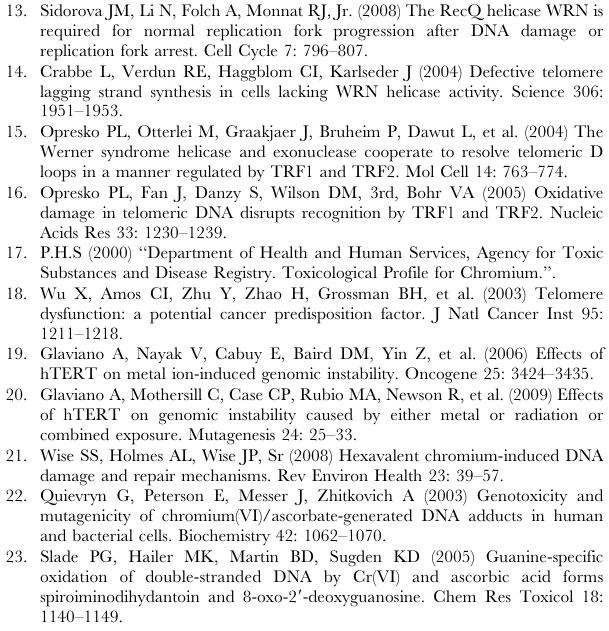
Table S1 Percent telomere defects (number of defects/number of chromosomes). The cells were exposed to the indicated Cr(VI) doses for 48 h and cultured in Cr(VI)-free medium for 10 h.